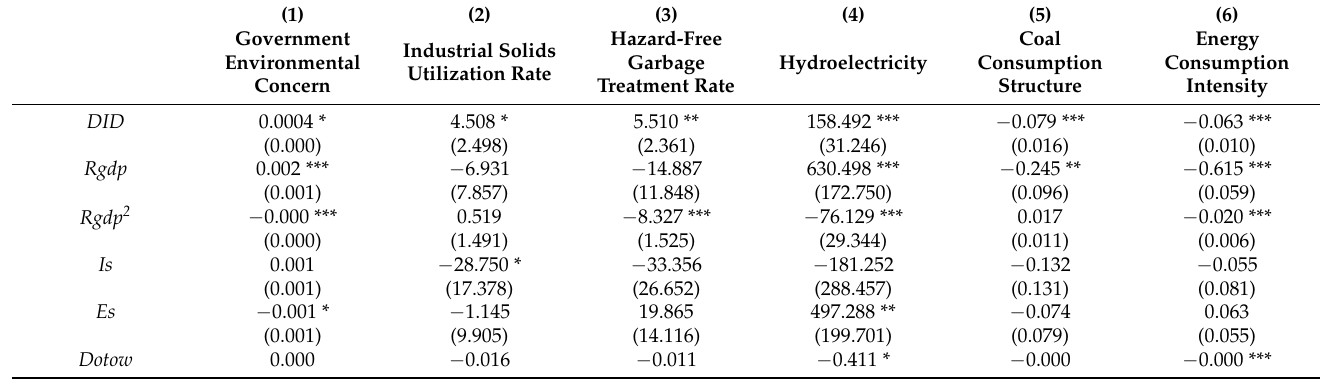
Table 7. Mechanism